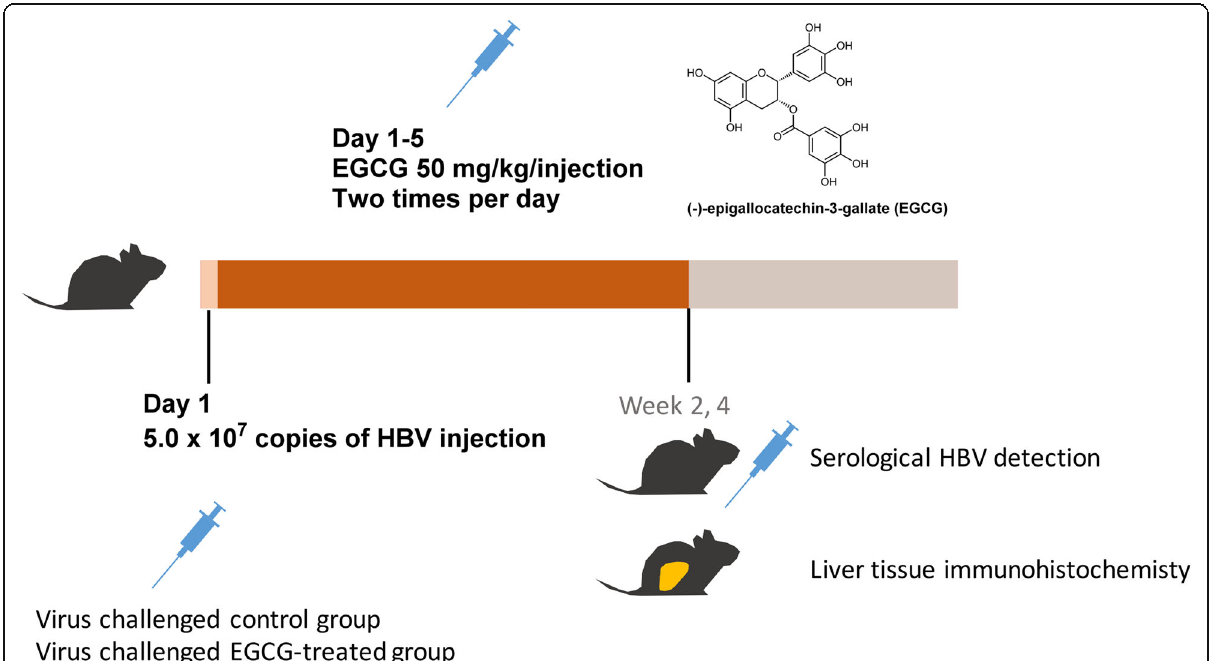
Fig. 3 Scheme of EGCG treatment and mouse challenge